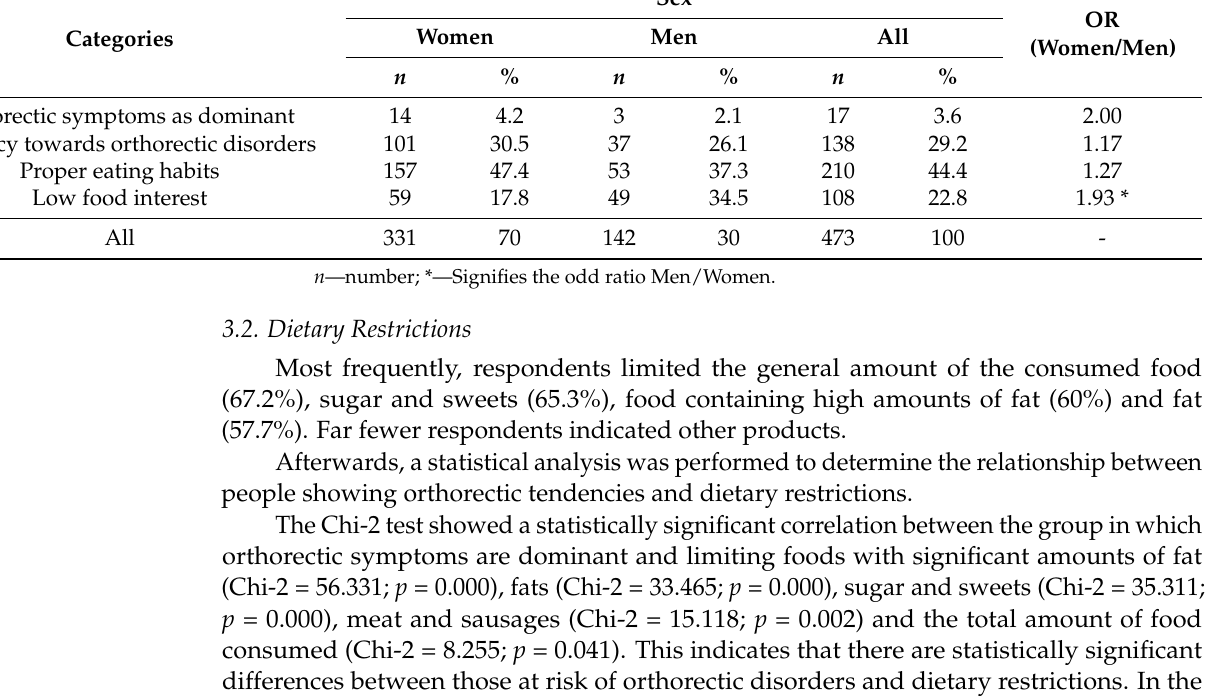
Table 1. Division of the research group into four categories based on the ORTO-6 questionnaire. Categories